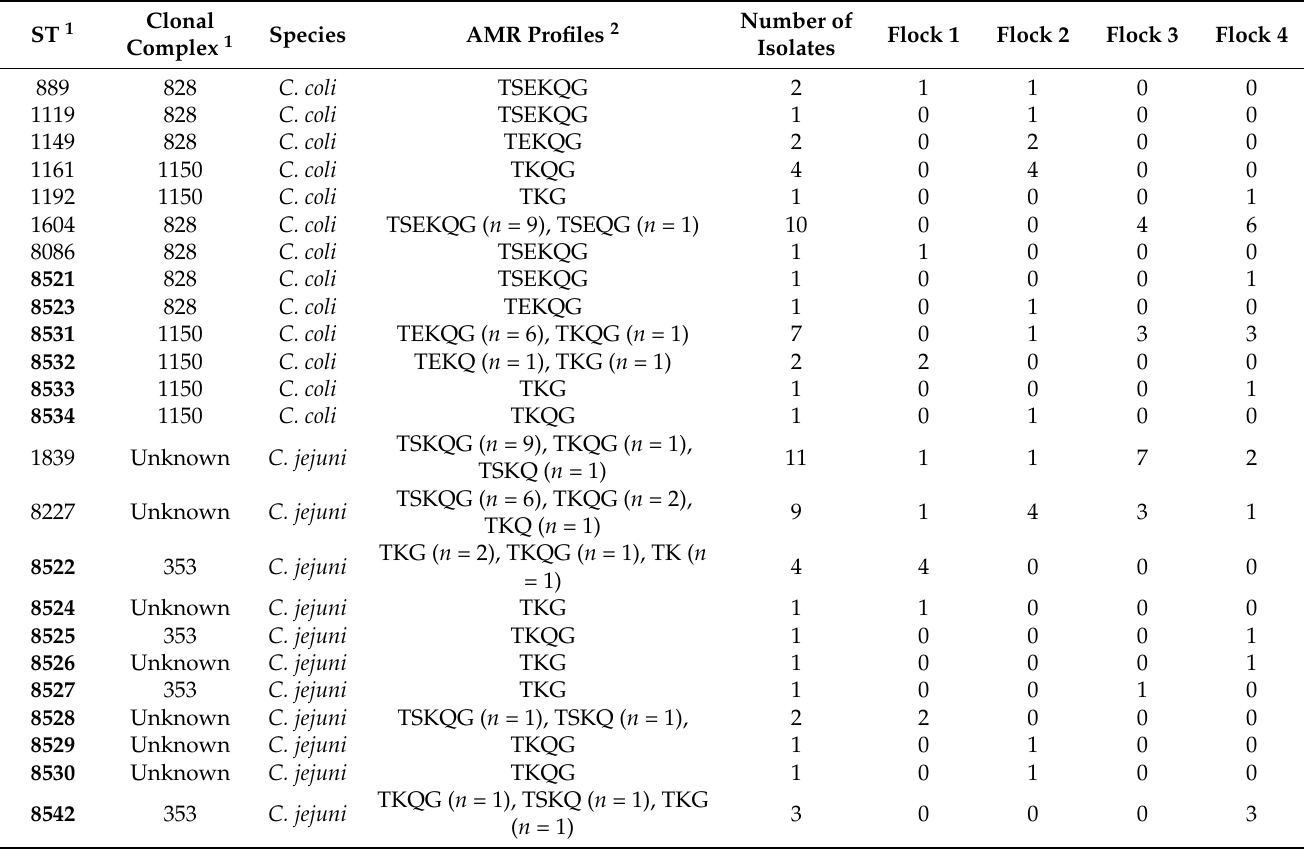
Table 3. Campylobacter jejuni and C. coli sequence types identified in the four turkey